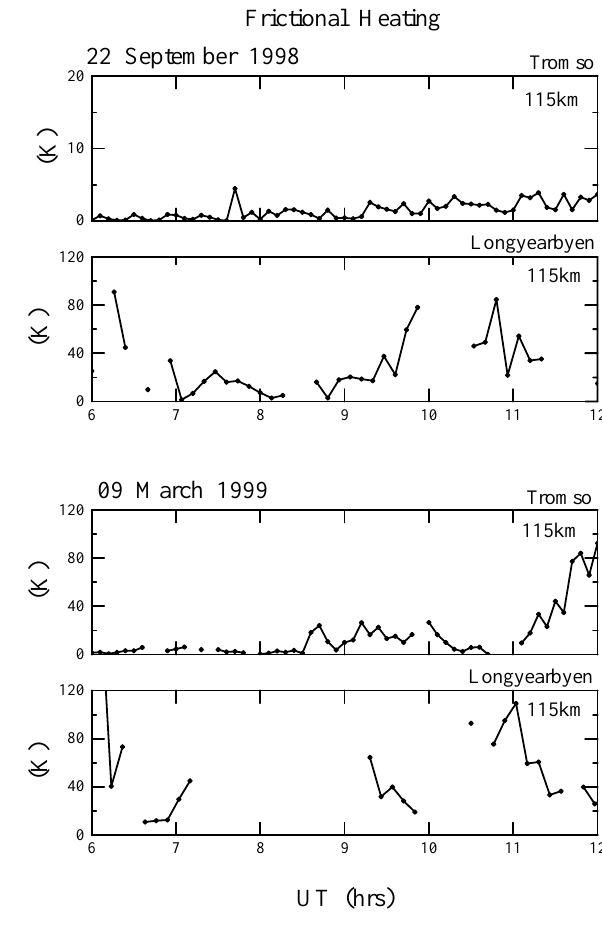
Fig. 8. Ion frictional heating β k m n ( V i − V n ) 2 /( 2 κ B ) in Kelvin units at 115km between 06:00 and 12:00UT at Tromsø and Longyearbyen on 22 September 1998 (the upper two panels) and 9 March 1999 (the lower two panels). The ion and neutral veloci- ties used to estimate the ion frictional heating were smoothed with five point running